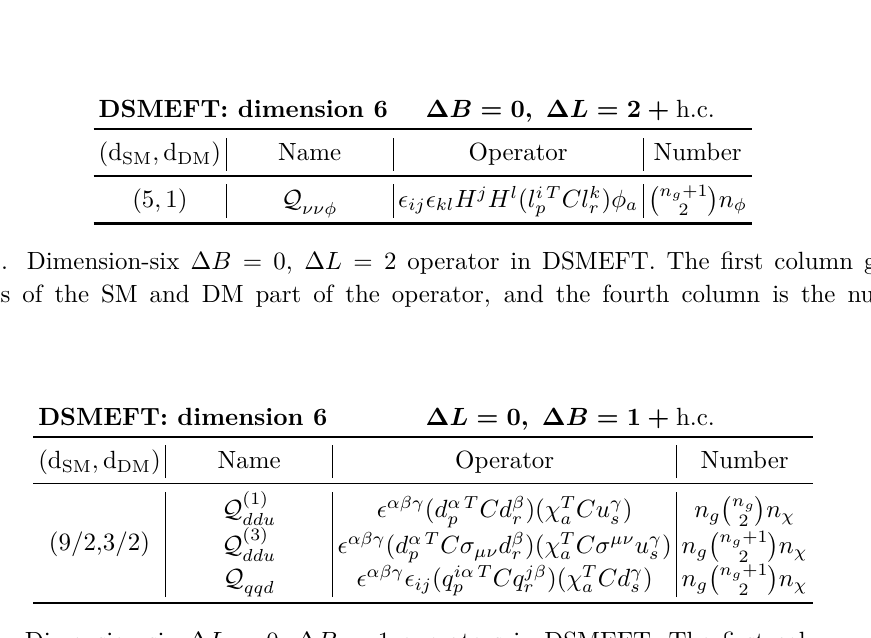
Table 17 . Dimension-six ∆ L = 0 , ∆ B = 1 operators in DSMEFT. The first column gives the dimensions of the SM and DM part of the operator, and the fourth column is the number of